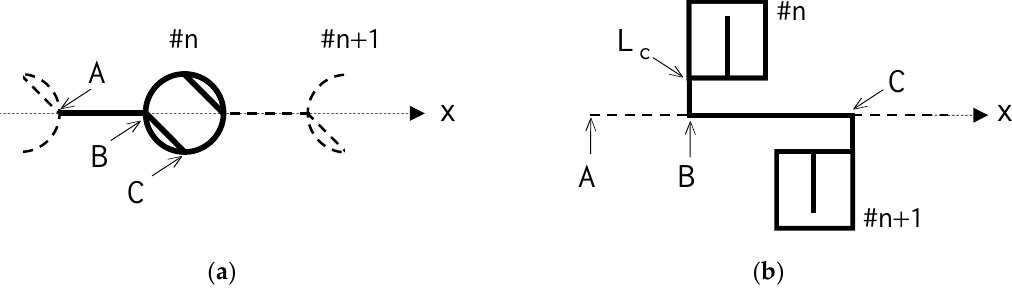
Figure 2. Antenna configurations in [3,7]: ( a ) bent line antenna [3]; ( b ) branched line antenna [7].